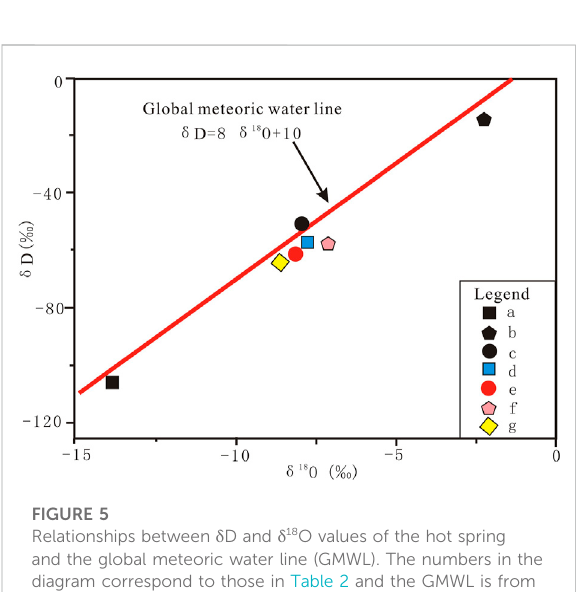
FIGURE 5 Relationships between δ D and δ 18 O values of the hot spring and the global meteoric water line (GMWL). The numbers in the diagram correspond to those in Table 2 and the GMWL is from Craig